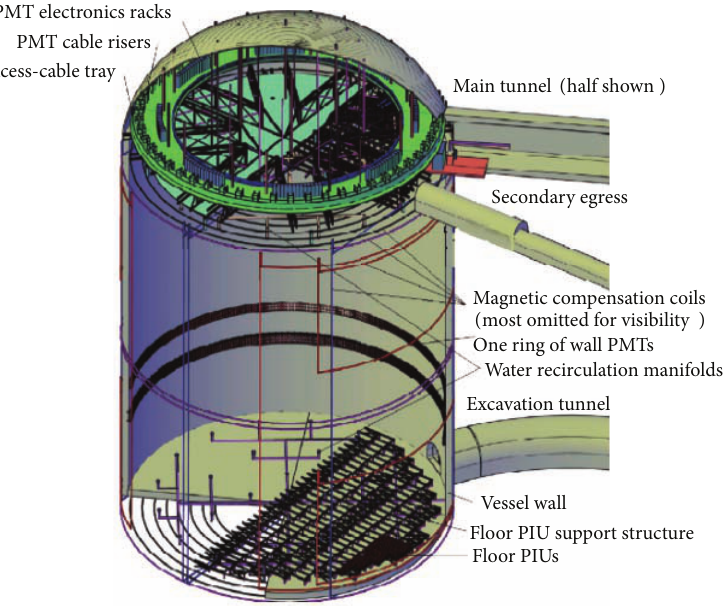
Figure 3: Schematic design of a 200 kt water Cherenkov detector in the Homestake underground facility.